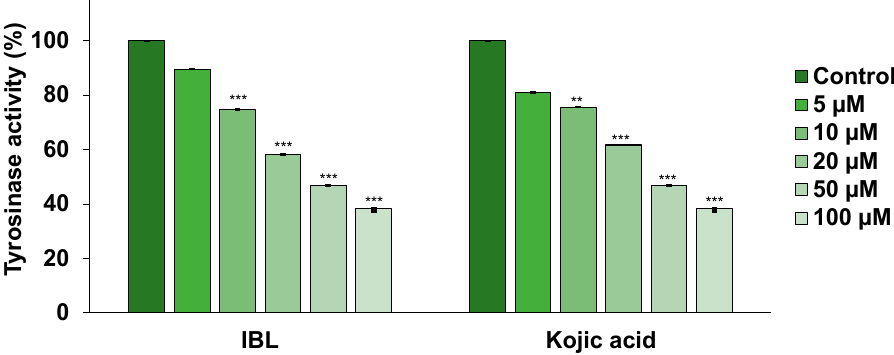
Figure 4. E ff ect of IBL on tyrosinase activity in B16F10 cells. B16F10 cells were stimulated with 100 µ M IBMX for 24 h after pretreatment with the indicated concentrations of IBL (5–100 µ M) or kojic acid (5–100 µ M) for 48 h. Tyrosinase levels were assayed by measuring L-DOPA oxidation at 475 nm using a microplate reader. Values are represented as means ± SEM. ( n = 3, ** p ≤ 0.01, *** p ≤ 0.001).